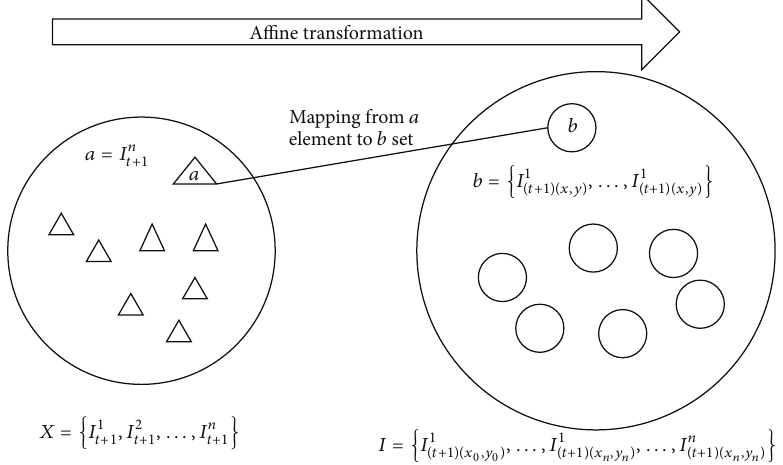
Figure 2: Affine transformation from 𝑋 to 𝐼 .